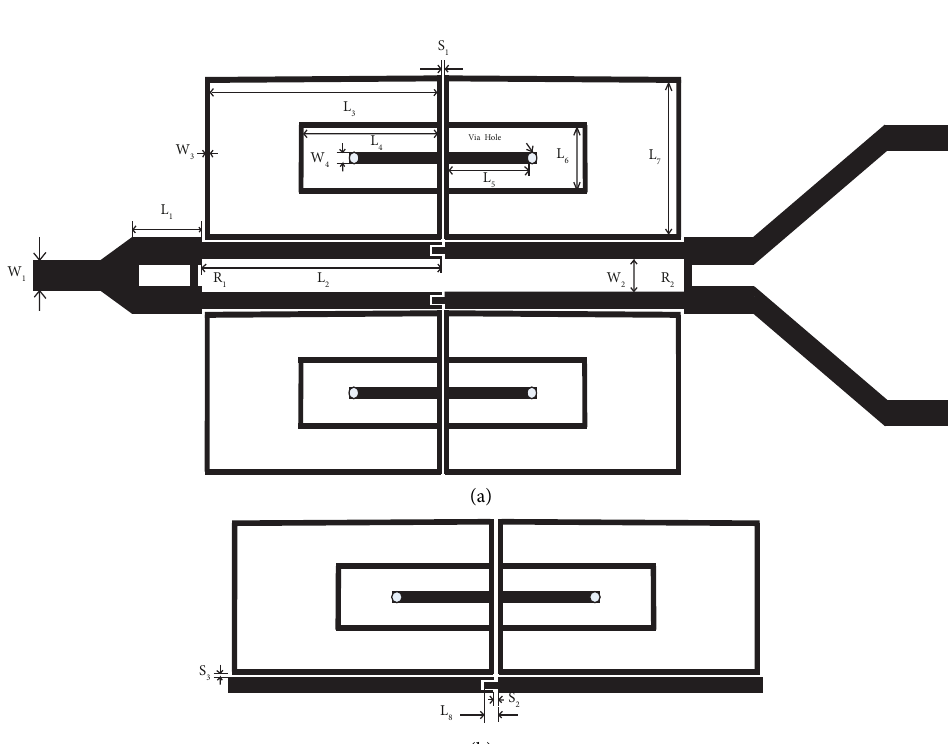
Figure 5: (a) Schematic of dual-mode flter power divider. (b) Te size of inter-digital coupling